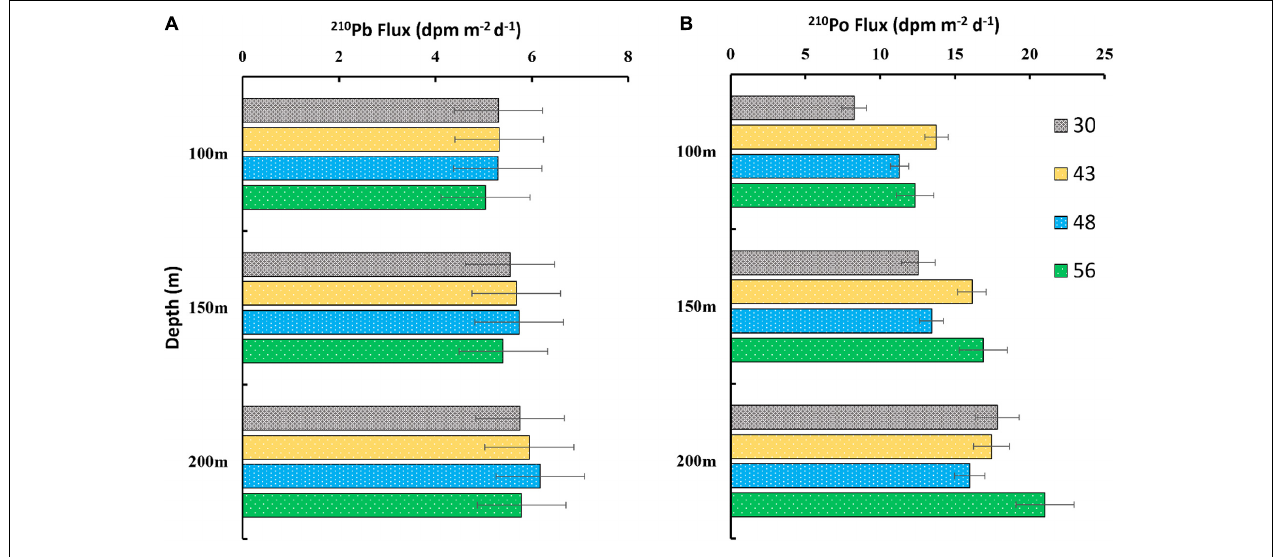
FIGURE 6 | (A) 210 Po and (B) 210 Pb fluxes calculated at 100 m, 150 m and 200 m